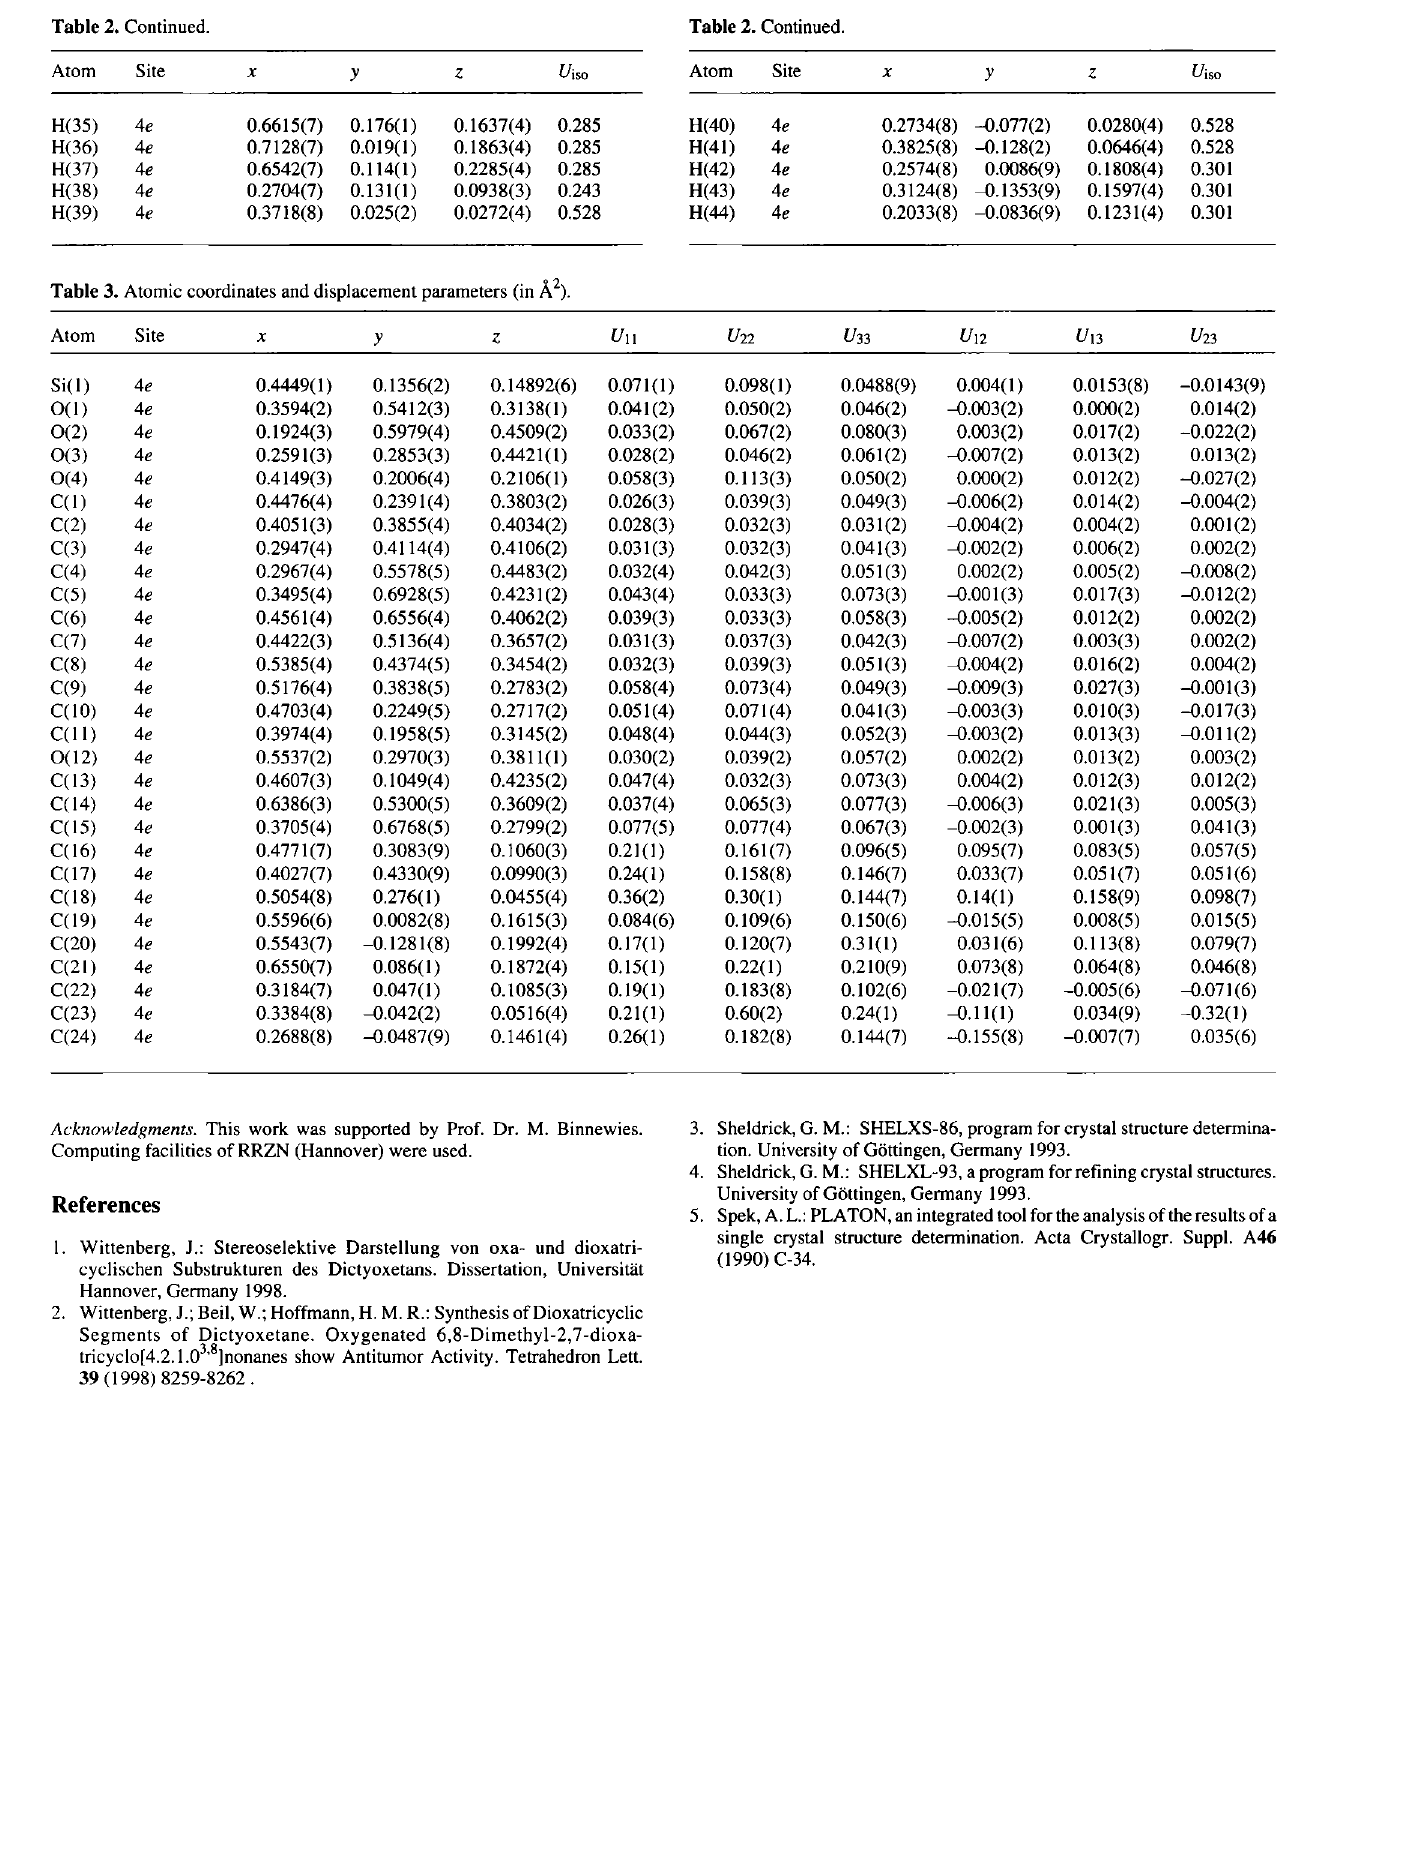
Table 3. Atomic coordinates and displacement parameters (in Ä 2